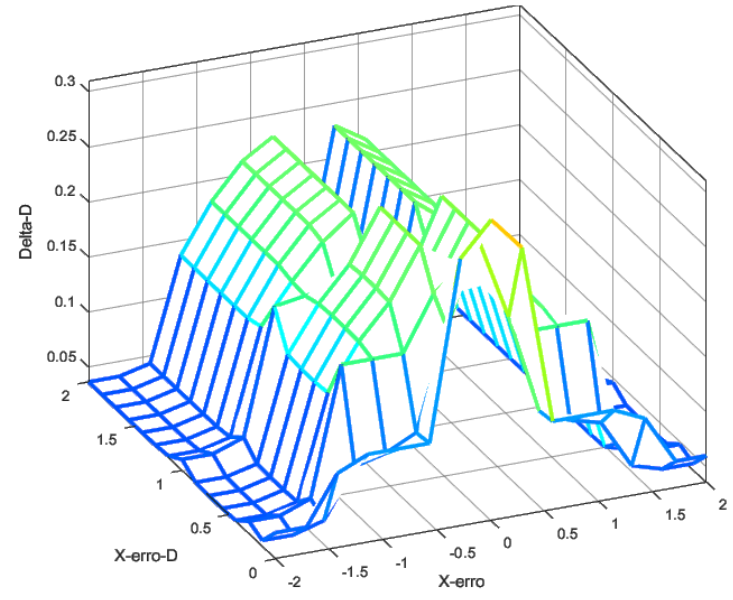
Figure 9. Fuzzy surface for derivative gain.